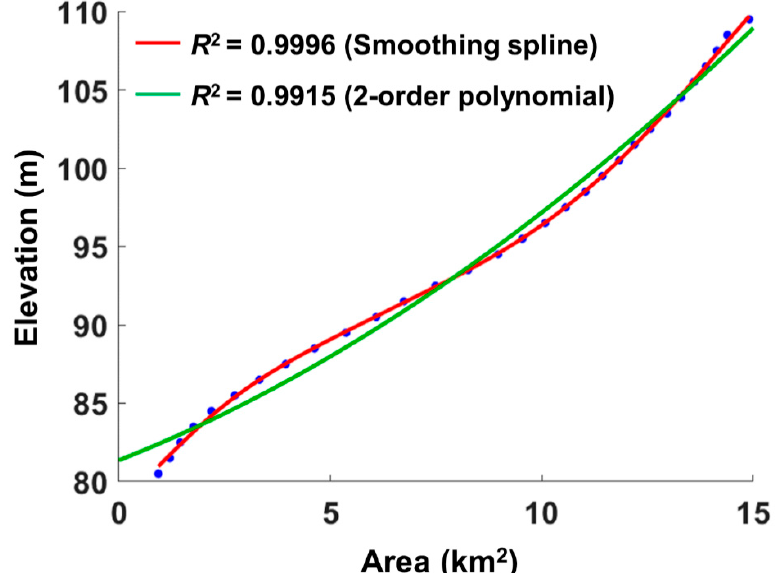
Figure 11. Area-elevation curve using the second-order polynomial function (green) and the smoothing spline model (red).